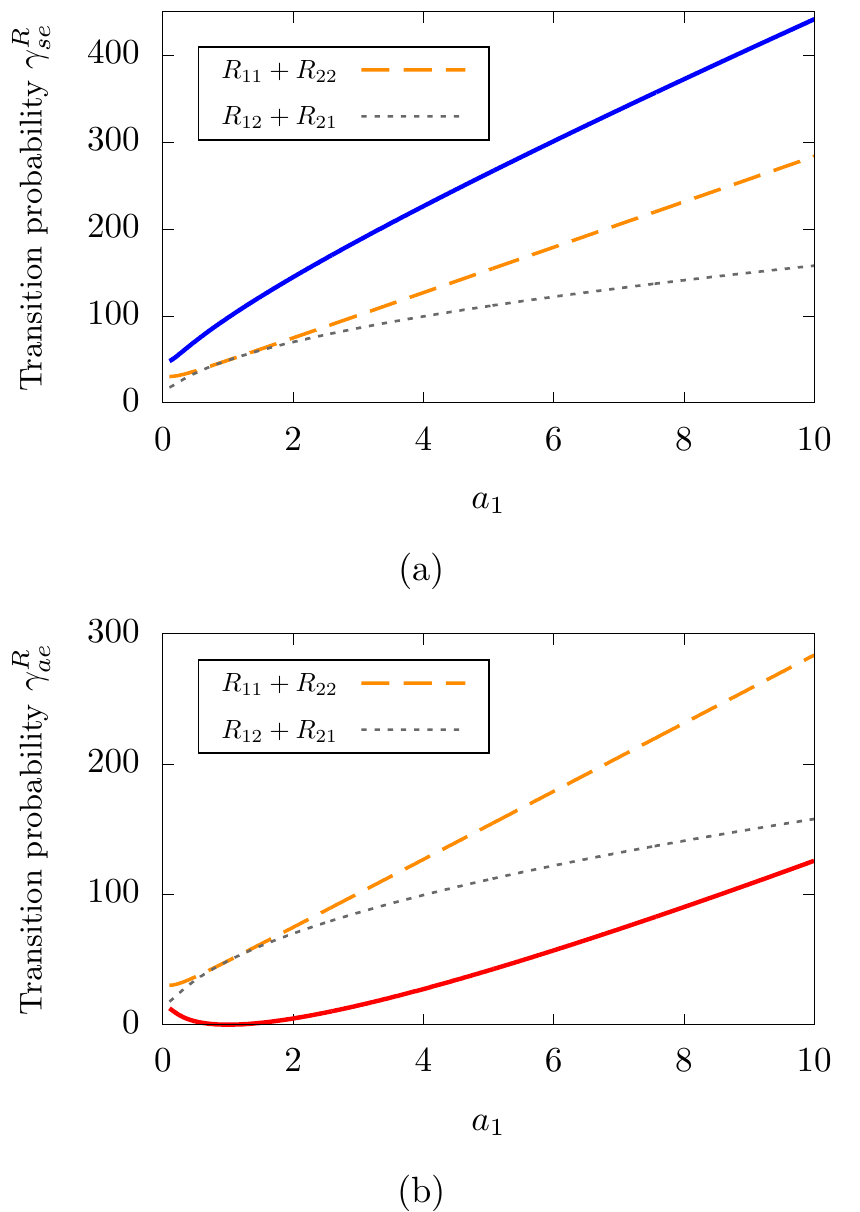
Figure 4 . (1 + 1) dimensions: (a) The transition probability from the symmetric state to the collective excited state for two observers with the Rindler modes, immersed in a thermal bath. The transition probability is denoted by solid blue line. (b) The transition probability from the anti- symmetric state to the collective excited state for two observers with the Rindler modes, immersed in a thermal bath, denoted by solid red line. In both of the cases a 2 = 1 is kept fixed and a 1 is varied. The other parameters are ∆ E = 0 . 1 , and β = 2 π . The orange dashed and gray dotted lines denote the contributions from ( R 11 + R 22 ) and ( R 12 + R 21 )